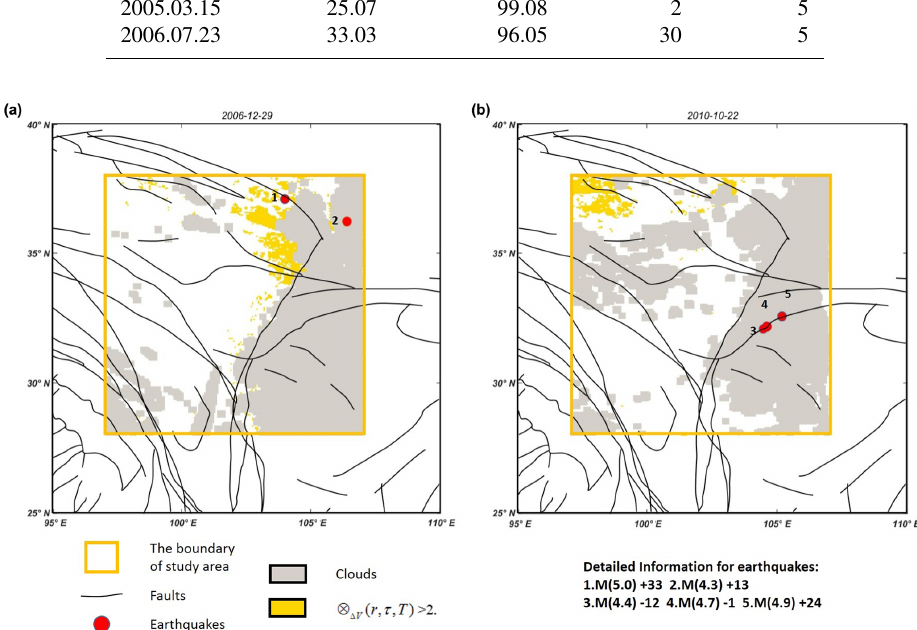
Figure 4. Two examples of the correlation between TIR anomalies and earthquakes: (a) is the TIR anomaly recorded on 29 December 2006 that corresponded to two earthquakes, and (b) is the TIR anomaly recorded on 22 October 2010 that did not correspond to earthquakes.